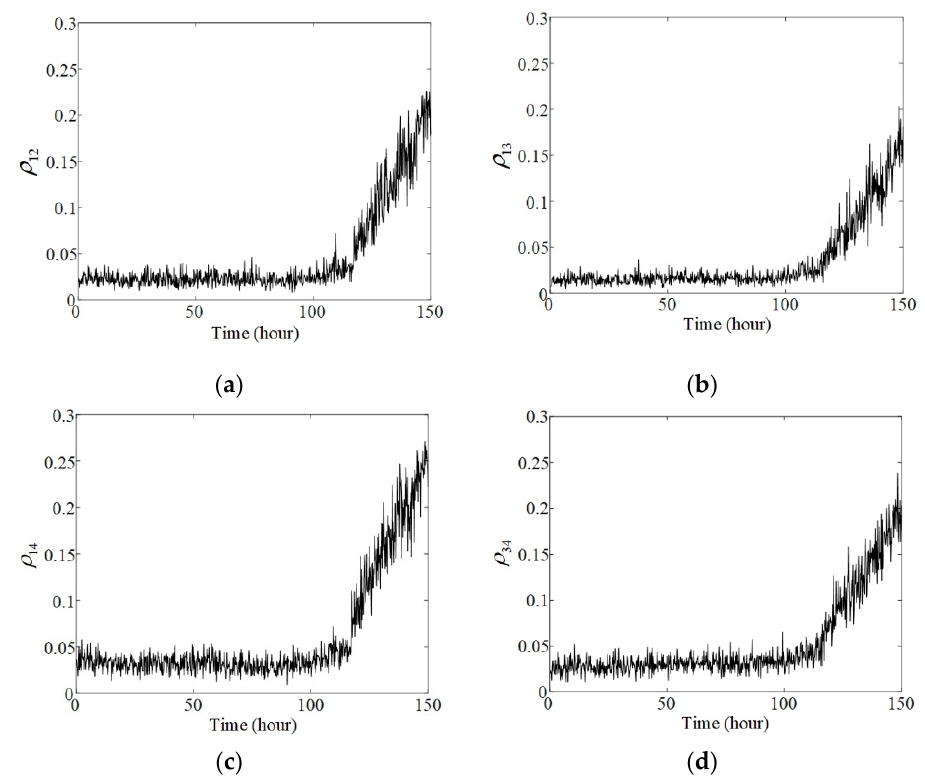
Figure 11. Phase synchronization indicator between ( a ) bearings 1 and 2; ( b ) bearings 1 and 3; ( c ) bearings 1 and 4; ( d ) bearings 3 and 4. bearings 1 and 4; ( d ) bearings 3 and